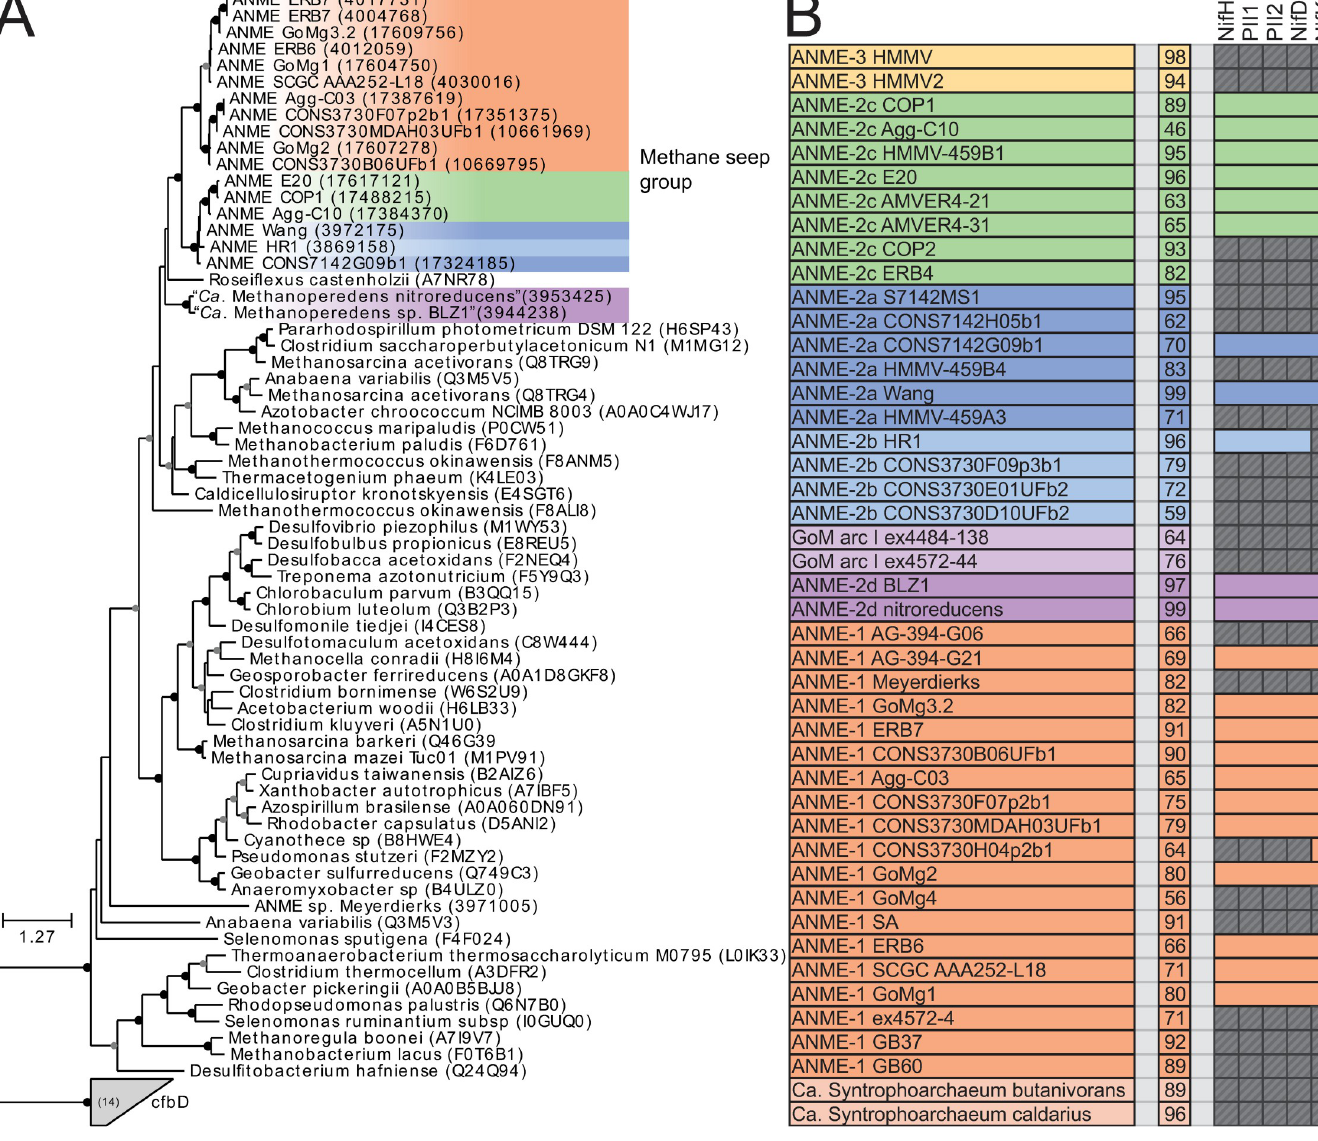
PLOS Biology | https://doi.org/10.1371/journal.pbio.3001508 January5,